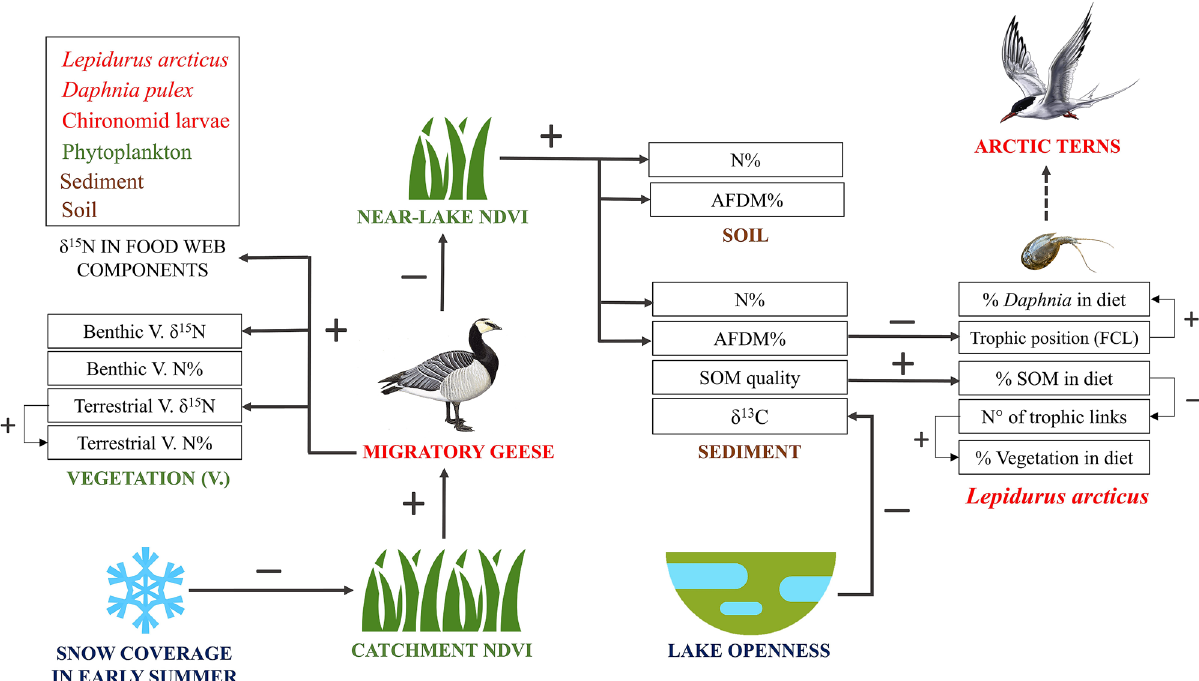
Figure 6. Schematic model showing the effects of abiotic factors (i.e. snow coverage and lake openness) and biotic factors (i.e. migratory geese and NDVI) on nutrient inputs and food webs in tundra ecosystems, as determined through the study of 18 shallow Arctic lakes and their catchment areas (Svalbard Islands). Colours indicate food web components, brown: substrate, green: primary producers, red: consumers. + and − indicate a significant positive and negative effect respectively (see Appendix 1 for model details). “Lake openness” is calculated as the lake-to-catchment surface area ratio. The higher this ratio, the lower the openness. Effects on the trophic niche and position of Lepidurus arcticus (Notostraca), a key species in the food web and the prey of other bird species, are shown. The trophic position of L. arcticus determined the maximum food chain length (FCL), as well the nutrient flow through the detritus or herbivore pathways in lake food webs. The dashed arrow indicates that Arctic Terns ( Sterna paradisaea ) were frequently observed preying on L. arcticus during this study, but this trophic link was not quantified. AFDM% and N%: ash free dry matter and N content respectively. SOM: sediment organic matter. δ 15 N (‰) and δ 13 C (‰): N and C stable isotope values respectively. Higher δ 15 N indicates increasing goose-derived N inputs. Lower δ 13 C in lake sediment indicates increasing terrestrial C